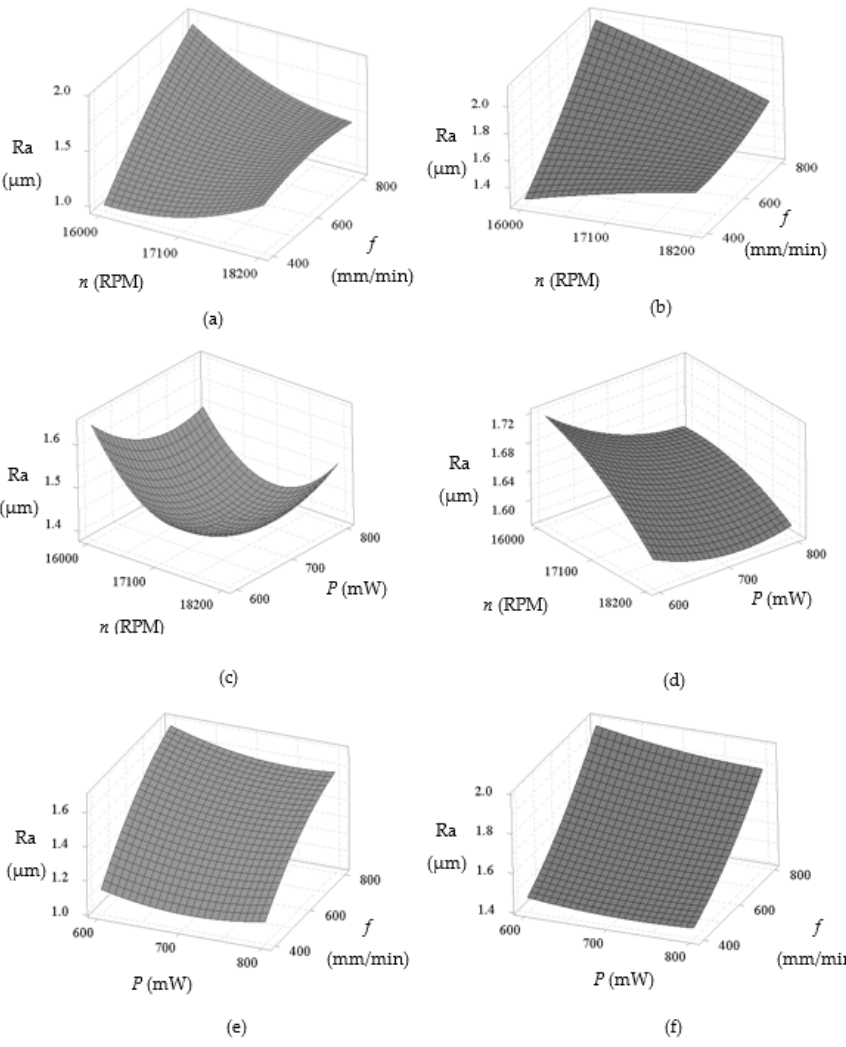
Figure 5. 3D response surface plots of surface roughness (Ra) in terms of spindle speed—feed rate for: ( a ) Water ‐ soluble sago starch cutting fluid and ( b ) conventional cutting fluid, spindle speed—power for: ( c ) Water ‐ soluble sago starch cutting fluid and ( d ) conventional cutting fluid, and power—feed rate for: ( e ) Water ‐ soluble sago starch cutting fluid and ( f ) conventional cutting fluid.